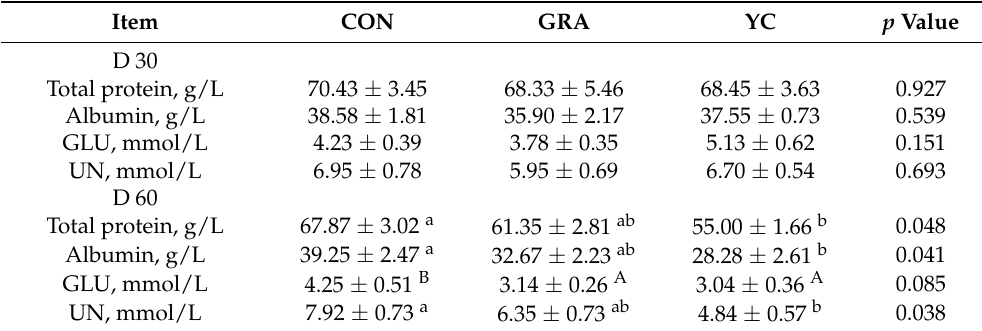
Table 6. Effect of dietary yeast culture supplementation on blood metabolites of growing– finishing pigs.